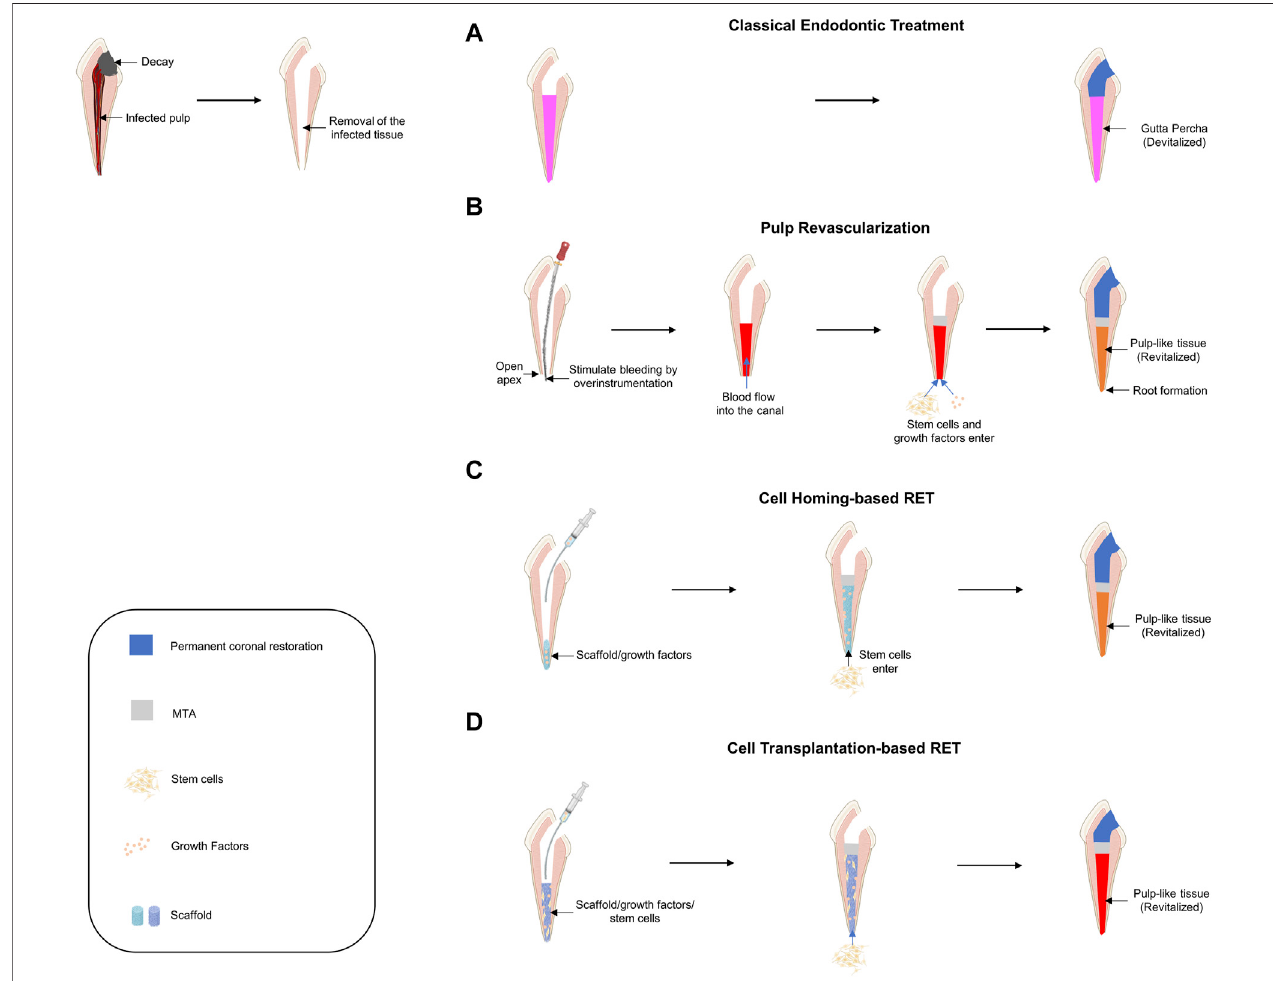
FIGURE4| Schematicdiagramofcurrentapproachesforpulptissueregeneration. (A) Classicalendodontictreatment. (B) Pulprevascularization. (C) Cell-homing- based regenerative endodontic treatment (RET). (D) Cell-transplantation-based RET.